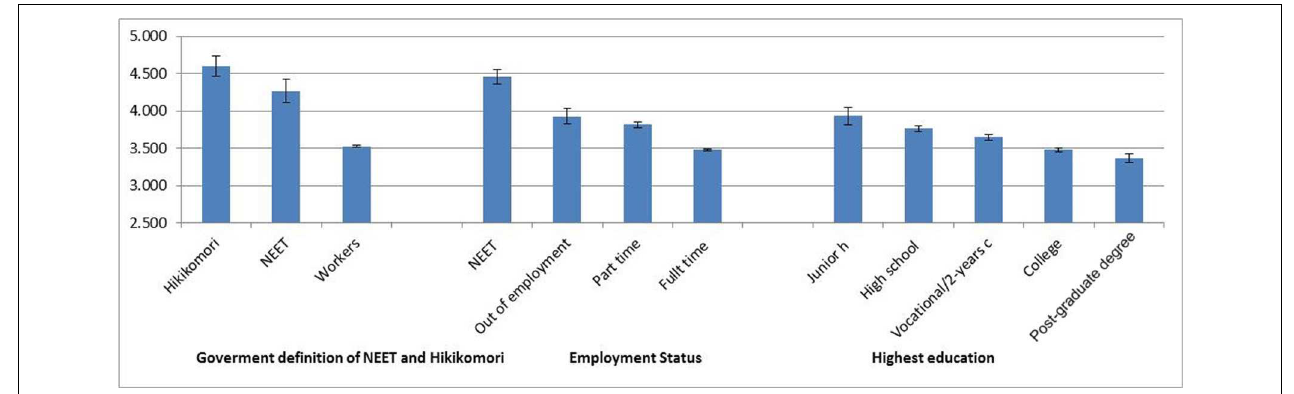
FIGURE 1 | NHR scores across demographic features in large sample (Study 2). Bars show 95% confidence intervals.